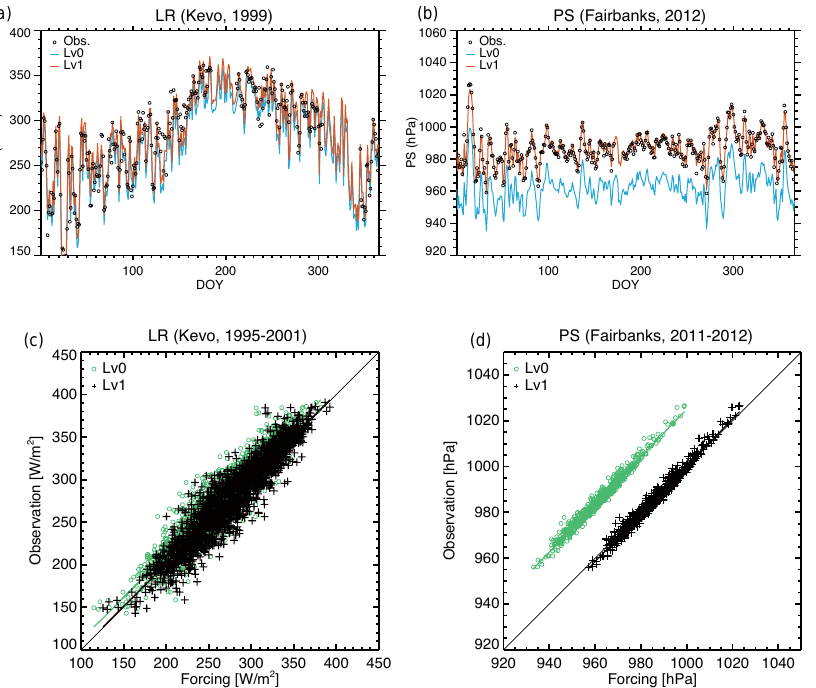
Figure 6. Comparison of GTMIP forcing data and observed values for (a) long-wave radiation (LR) of Kevo (in 1999), and (b) surface pressure (PS) of Fairbanks (in 2011) on a daily basis. Level 0 data are shown in blue and level 1 data in red. Correlation between the forcing data sets and observed values for these examples are also shown for (c) LR of Kevo (in 1995–2001), and (d) PS of Fairbanks (in 2011–2012). Level 0 data are shown in green and level 1 data in